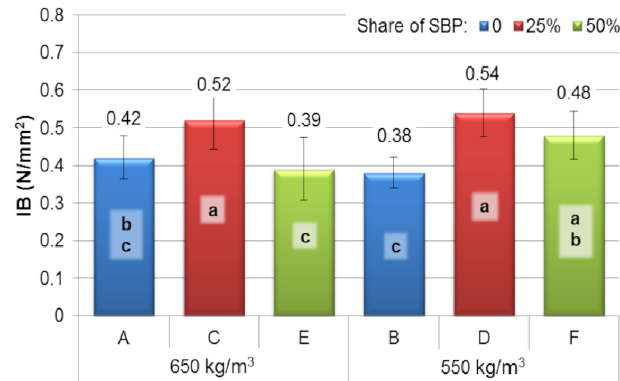
Figure 3. Internal bound of particleboards. a,b,c—homogenous group by Tukey test ( α = 0.05).